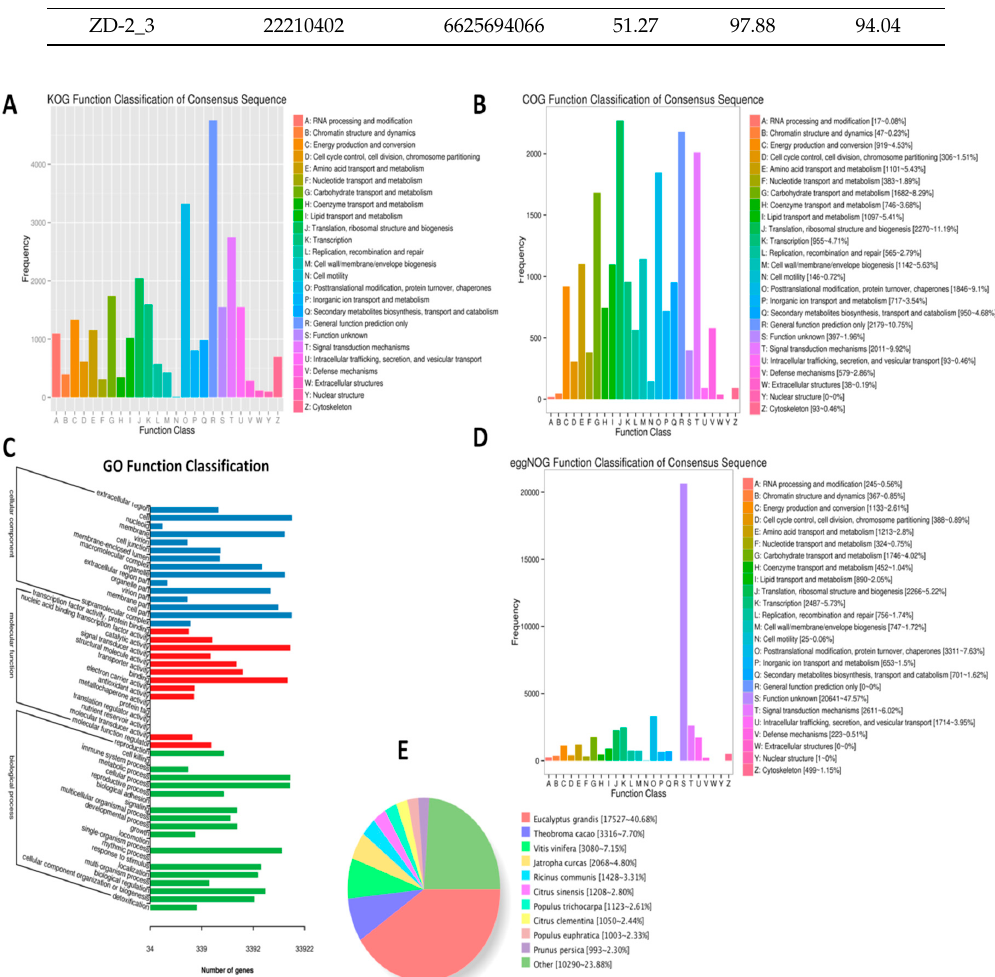
Figure 2. Functional annotation of the unigenes detected in L. indica based on orthologs from various databases. ( A ) KOG; ( B ) COG; ( C ) GO; ( D ) EggNOG; and ( E ) NR database homologous species distribution analysis.